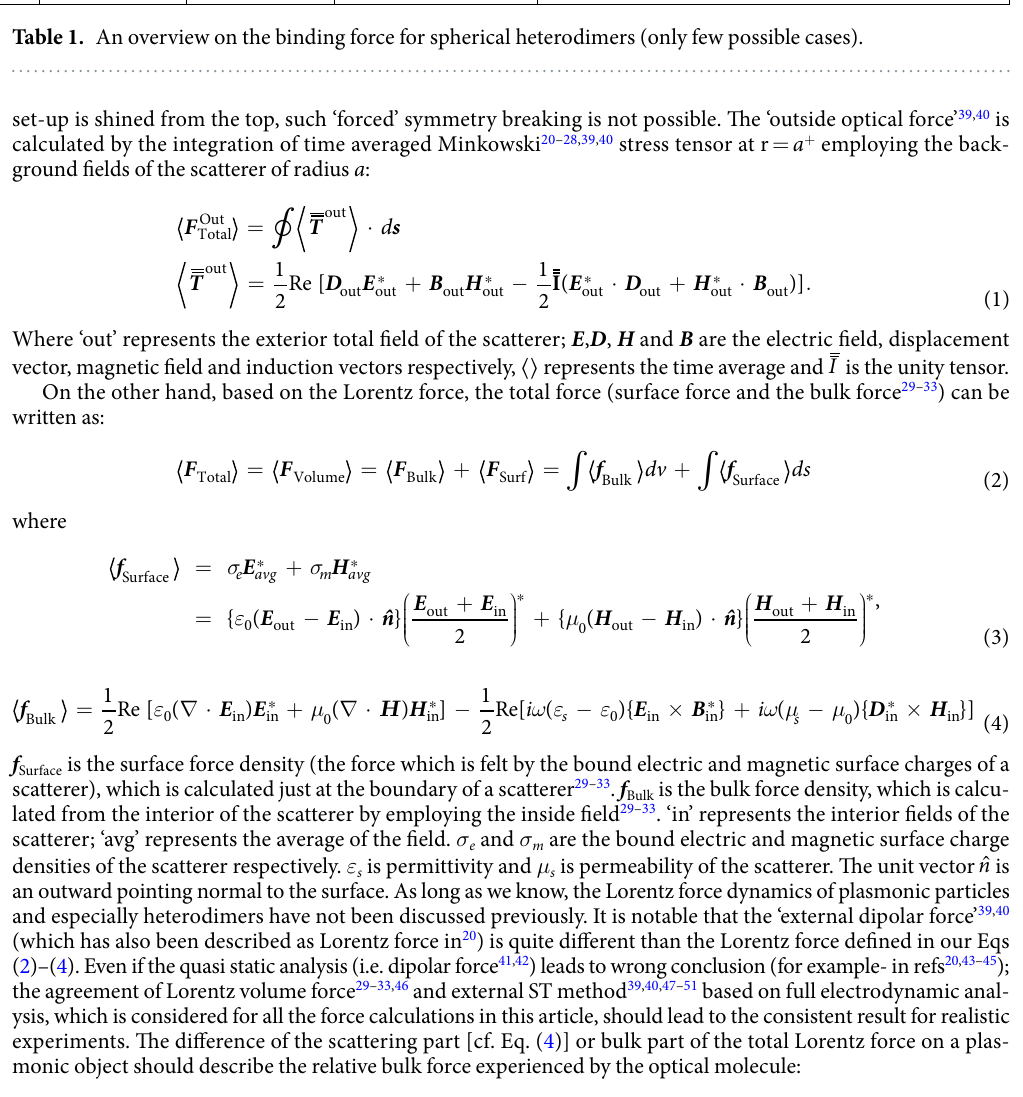
Lateral near field binding force reverses only for perpendicular polarization. For higher wavelength region: Reversal of force occurs due to zero surface and bulk Lorentz force at a specific wavelength near bonding (attractive force) resonance. For lower wavelength region: such force reversal can be recognized from the reversal of electric dipole moment of the smaller object. In fact, such reversals (repulsive to attractive) occur due to induced electric resonance near the bonding resonance mode. Notably, for the parallel polarization, the presence of Fano resonance cannot help to reverse the binding Longitudinal near field binding force reverses [for only Ag-Au and Ag-Ag case] only when the bigger particle rotates and the light is perturbed by the fixed smaller object at first. This reversal occurs due to the constructive dipole-quadrupole resonance and due to the dominance of the bulk Lorentz force. However, for all heterodimer sets attractive and repulsive force can be very easily controlled by changing the light propagation direction or changing the relative orientation of the dimers. Such control is not possible with the spherical